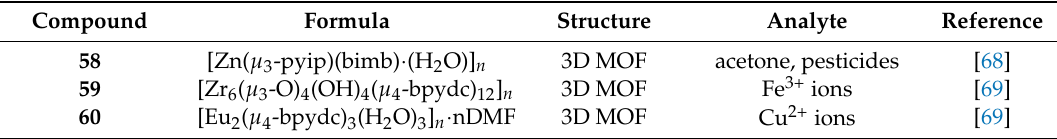
Table 11. Selected examples of MOFs with selective sensing